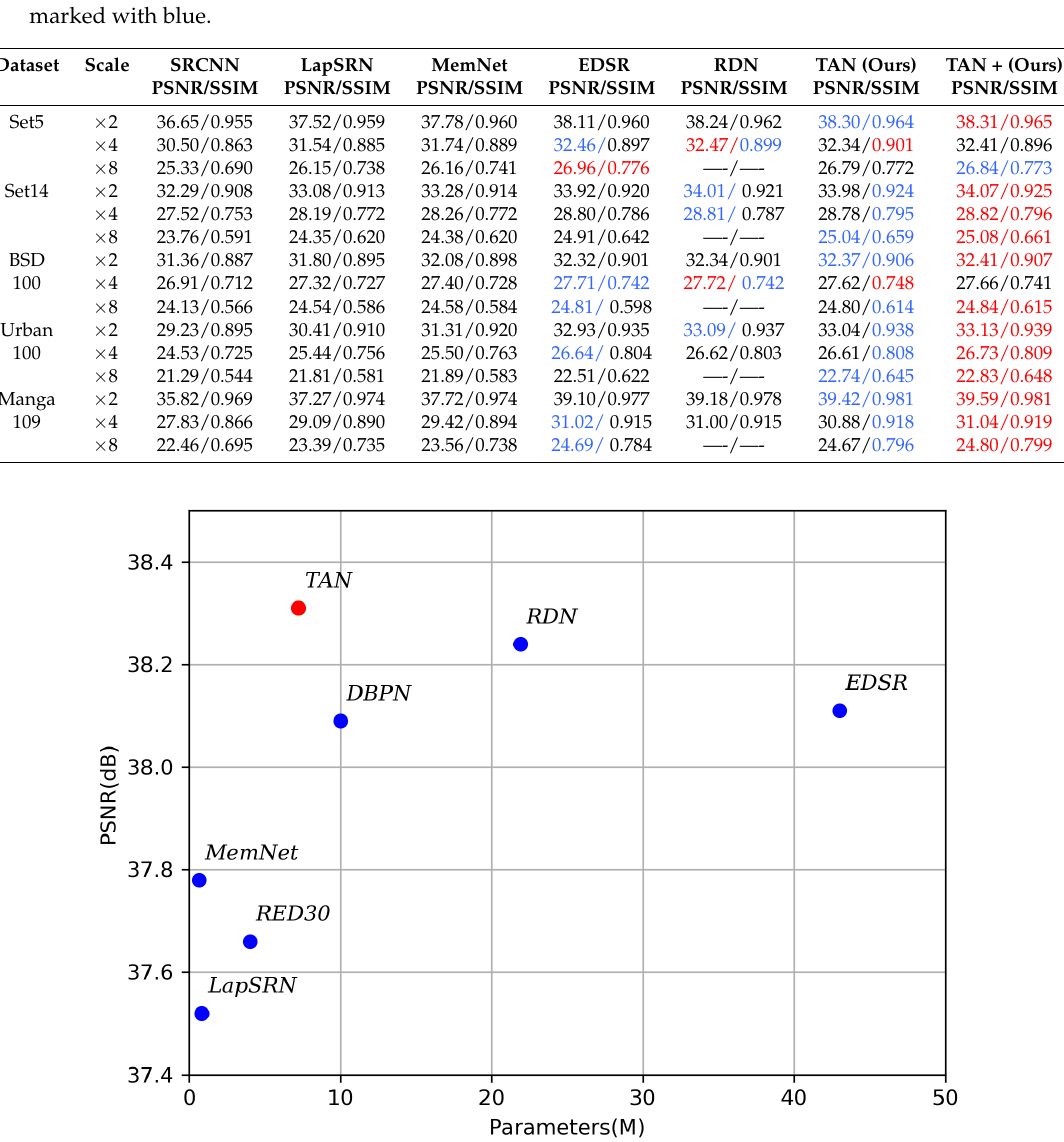
Figure 7. Performance and parameter comparison of scale × 2 reconstructed for images in Set5. learning-based methods LapSRN [5], MemNet [8], RED [28], DBPN [27], EDSR [4] and RDN